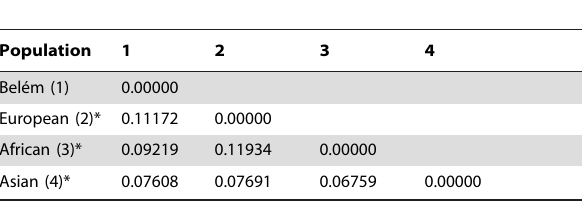
Table 4. The F ST values for pairwise comparisons of haplotype frequencies of the FUT3 gene between the present study and other